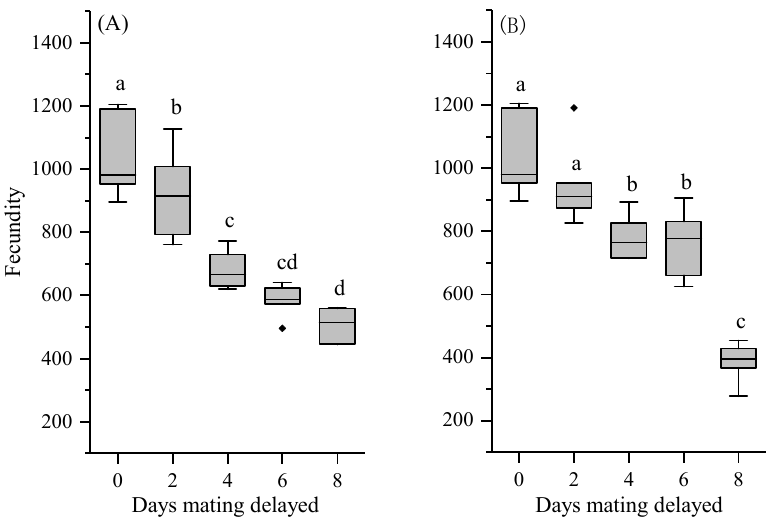
Figure 2. Fecundity of Henosepilachna vigintioctopunctata after female-delayed ( A ) and male-delayed ( B ) mating for 0–8 d. Box plots with the same letters are not significantly different ( p > 0.05). The height of the box shows the upper and lower quartiles; the whiskers indicate the upper and lower extremes. The horizontal line in the middle of the box is the median point (half above and half below) of the data. The dots on the outside of the box indicate outliers.